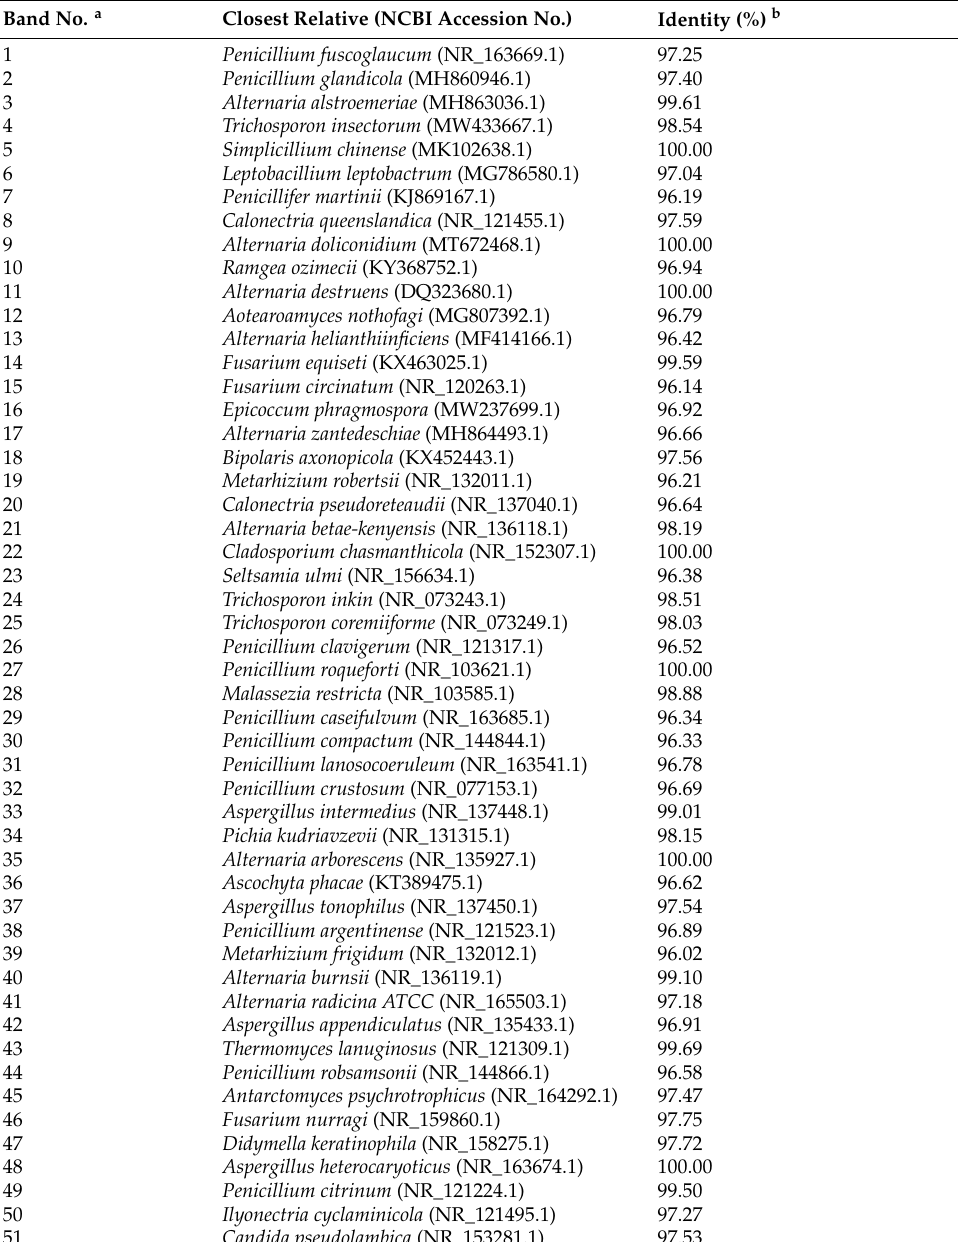
Table 2. BLAST Identified gene sequences of ITS—derived bands excised from a DGGE gel. Band No. a Closest Relative (NCBI Accession No.) Identity (%)